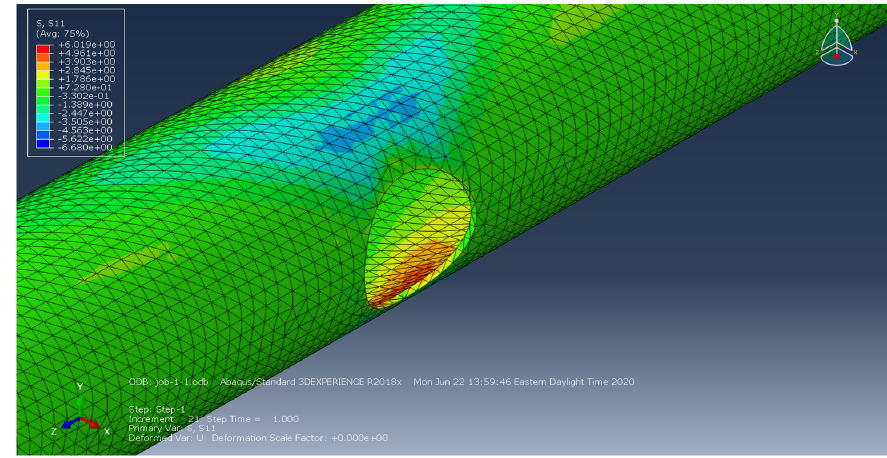
Figure 20. Aspect ratio 1-1 in transverse (X) direction.